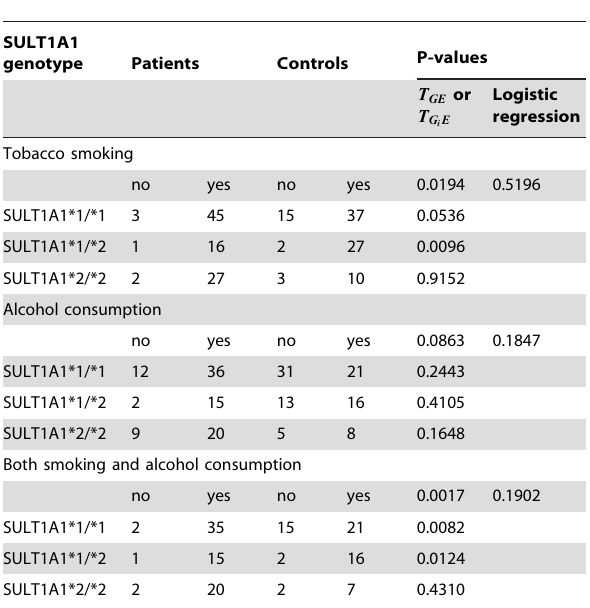
Table 5 . Comparison of p-values for the mutual information- based statistics and logistic regression to the interaction between the gene SULT1A1 and smoking (alcohol consumption) in the Mixed Ancestry South African